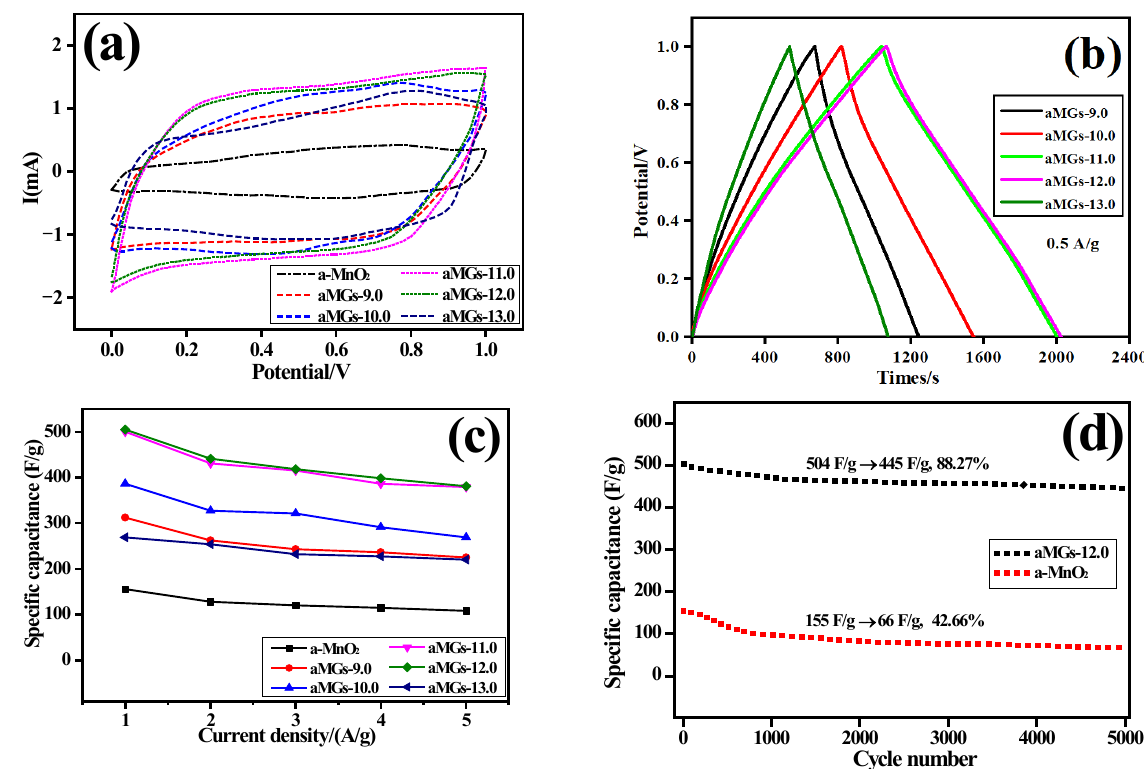
Figure 9. ( a ) CV curve of αMGs -X samples at a scanning rate of 5 mV·s −1 . ( b ) GCD curves at a current density of 0.5 A . g −1 . ( c ) Specific capacitance at different current densities. ( d ) Relationship between specific capacitance of αMGs - 12.0 and α -MnO 2 and number of cycles at a current density of 0.5 A·g −1 .